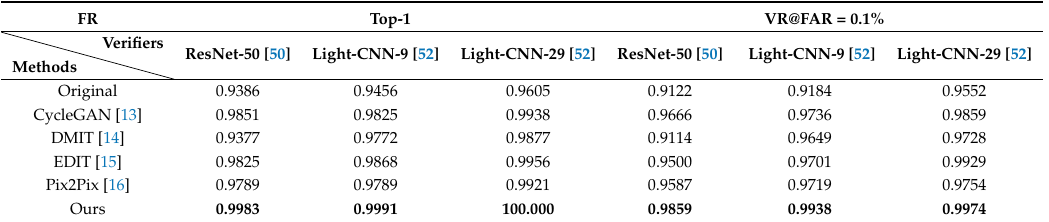
Table 2. Top-1 identification accuracy and verification accuracy at 0.1% FAR on the MultiPIE dataset using ResNet-50, Light-CNN-9 and Light-CNN-29. FR Top-1 VR@FAR = 0.1%